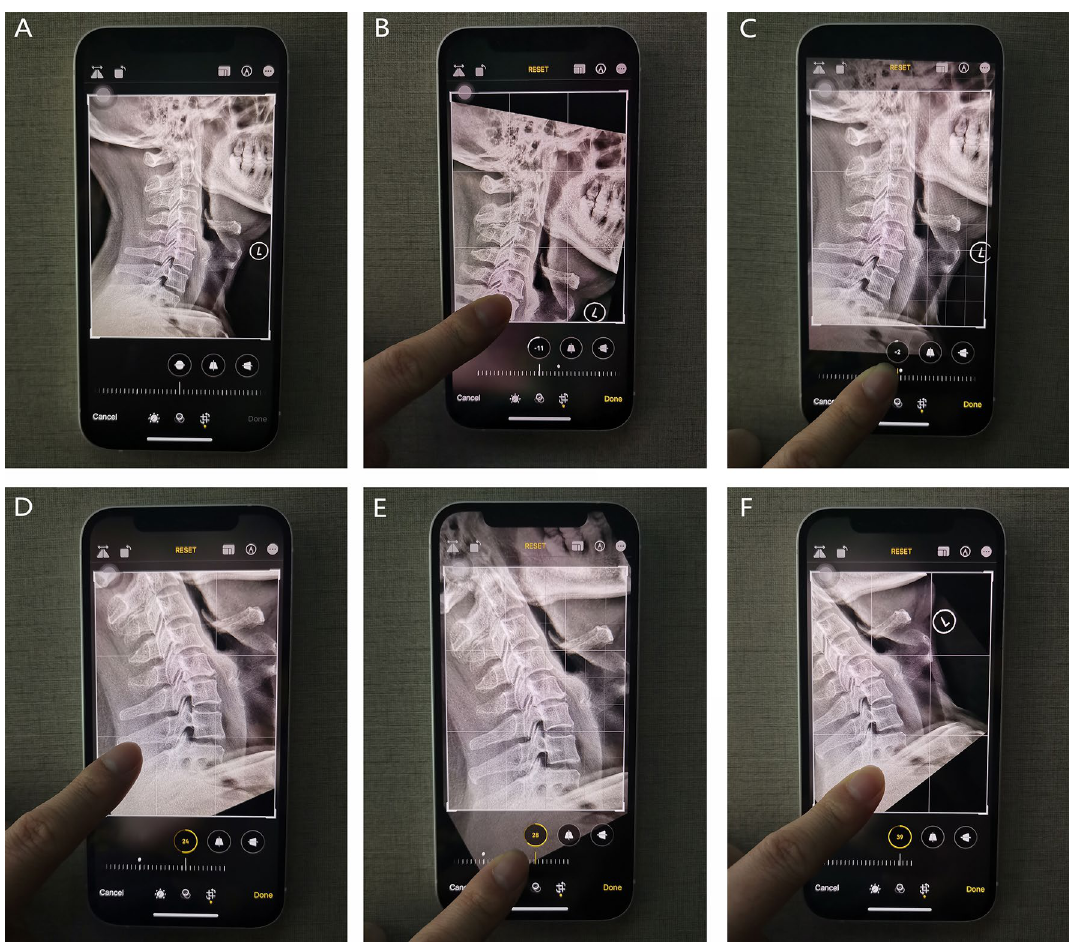
Figure 2. Measurement of the C0-2 Cobb angle, C2-7 Cobb angle, T1S and NT by the iPhone’s intrinsic photo edit function. ( A) The targeted photo was selected to be edited. ( B ) The photo was rotated until the McGregor line overlapped or was parallel to the horizontal grid lines, and then this angle was recorded. ( C ) The photo was rotated until the lower endplate of C2 overlapped or was parallel to the horizontal grid lines, and then this angle was recorded. ( D ) The photo was rotated until the lower endplate of C7 overlapped or was parallel to the horizontal grid lines, and then this angle was recorded. ( E ) The photo was rotated until the upper endplate of T1 overlapped or was parallel to the horizontal grid lines, and this angle was recorded. ( F ) The photo was rotated until the line connecting the sternum’s upper end and the centre of the T1 upper endplate was overlapping or parallel to the horizontal grid lines, and this angle was